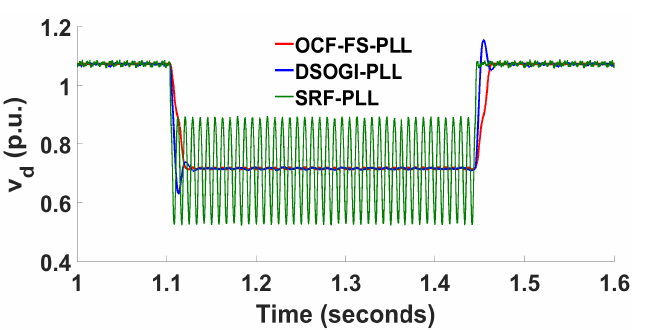
Figure 8. The v g , d positive sequence component during unbalanced grid voltage sag in two